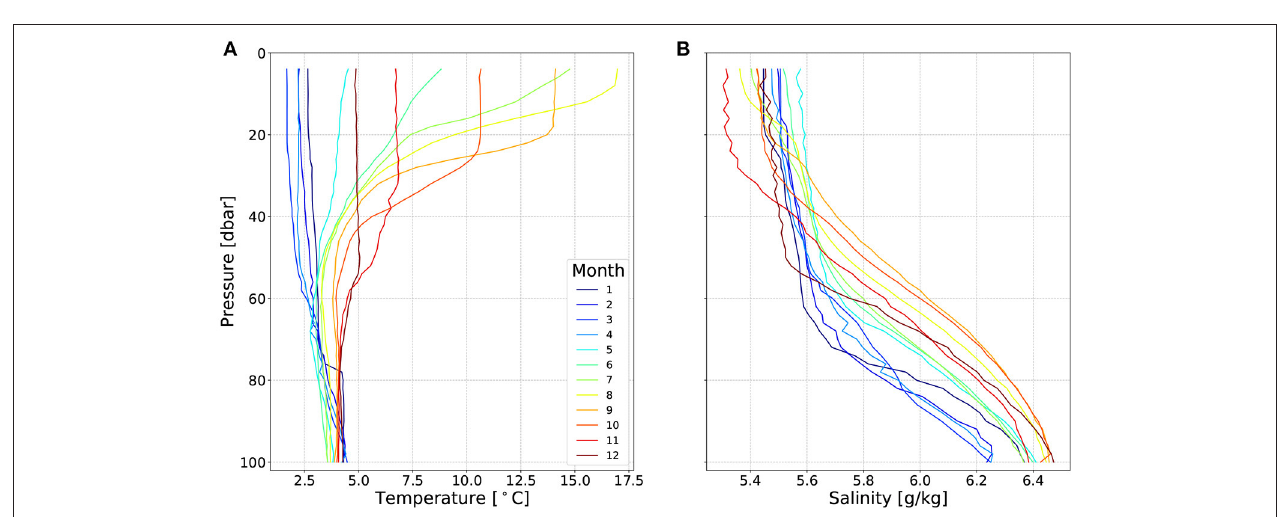
FIGURE 4 | Monthly mean profiles of (A) temperature and (B) salinity from Argo data. Profiles for months 1–4 include only 2015–2017 data due to lack of profiles and the other months include the entire dataset period of 2012–2017. Data above 4dbar and below 100dbar were cut off due to sparse measurements.